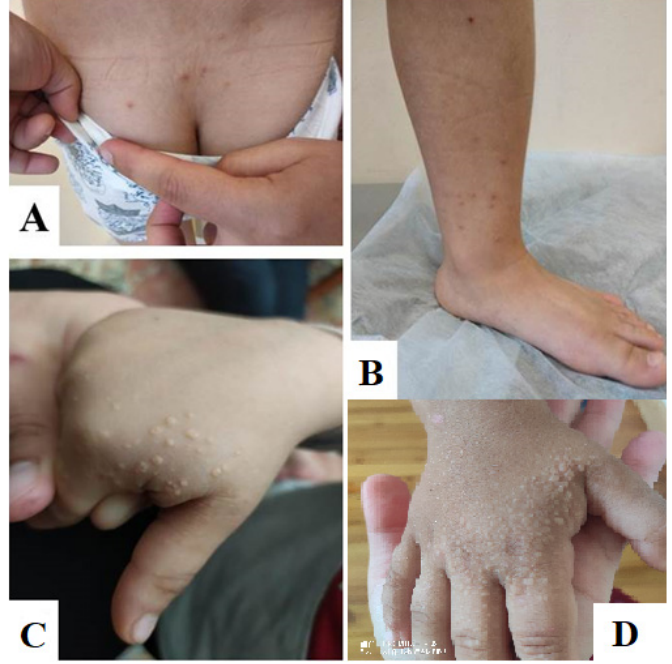
Figure 2. Phenotypic signs of HTG in the patient. ( A , B ) Small-cell reddish rash in the lumbar region and lower third of the legs. ( C , D ) Small-cell rash on the dorsum of the hands and in the interdigital spaces ( C ) at 4 years old and ( D ) 5 years old.